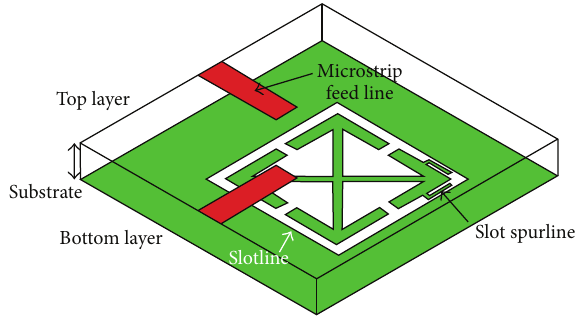
Figure 6: The three-dimensional view of the miniaturized square resonator.